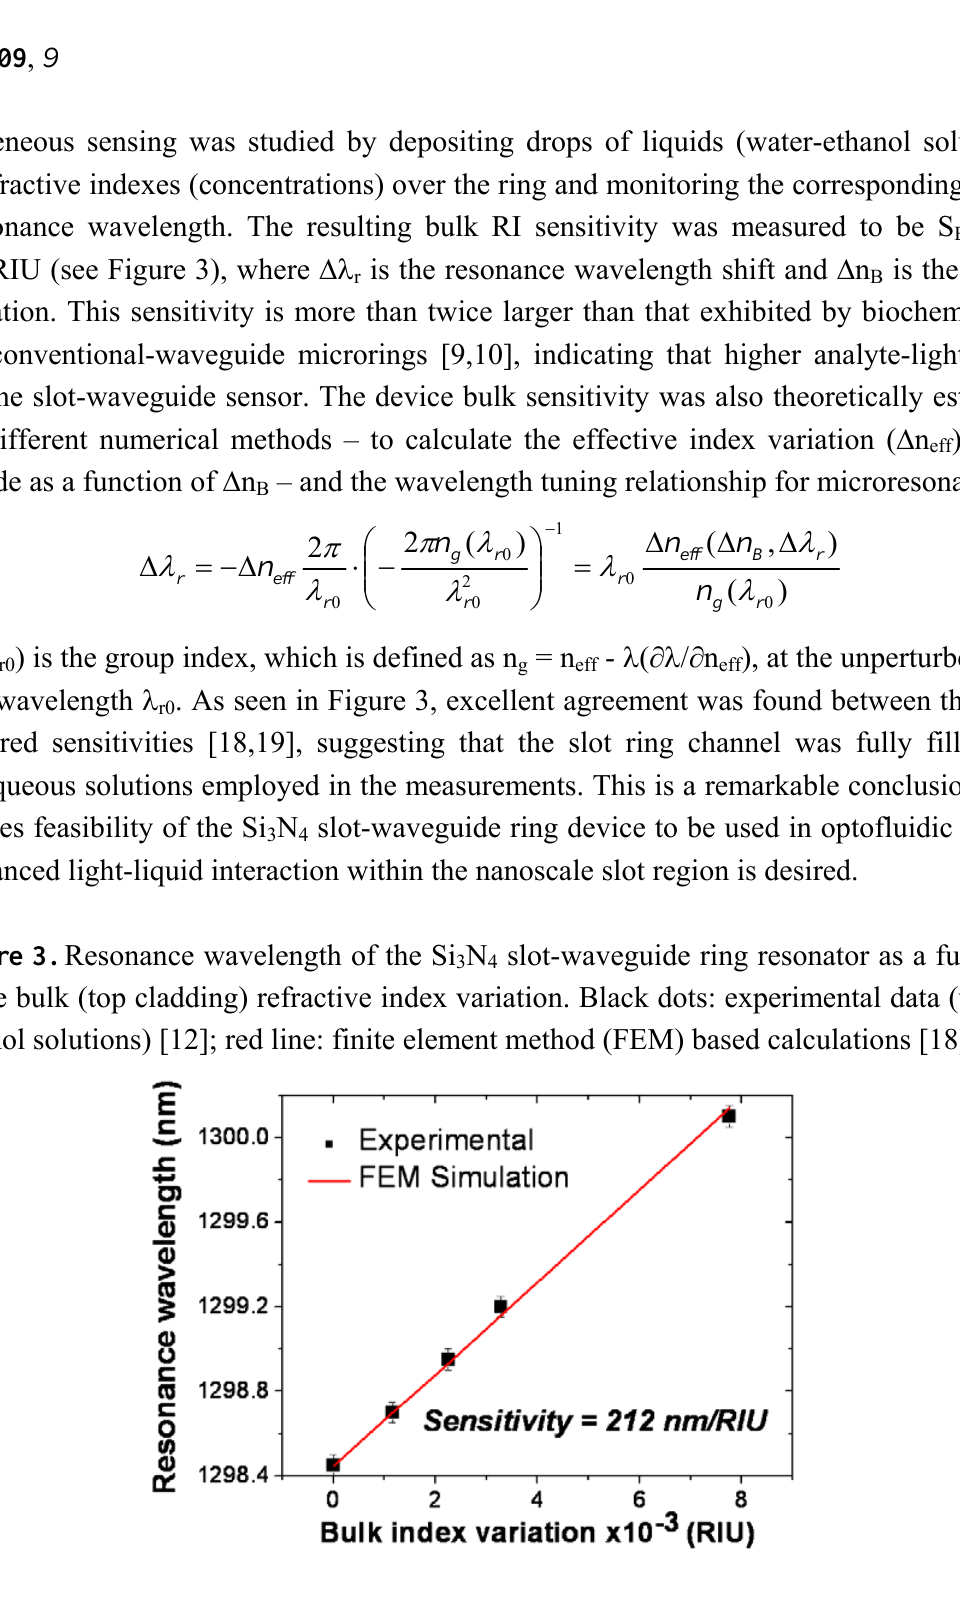
N slot-waveguide ring resonator as a function 3 4